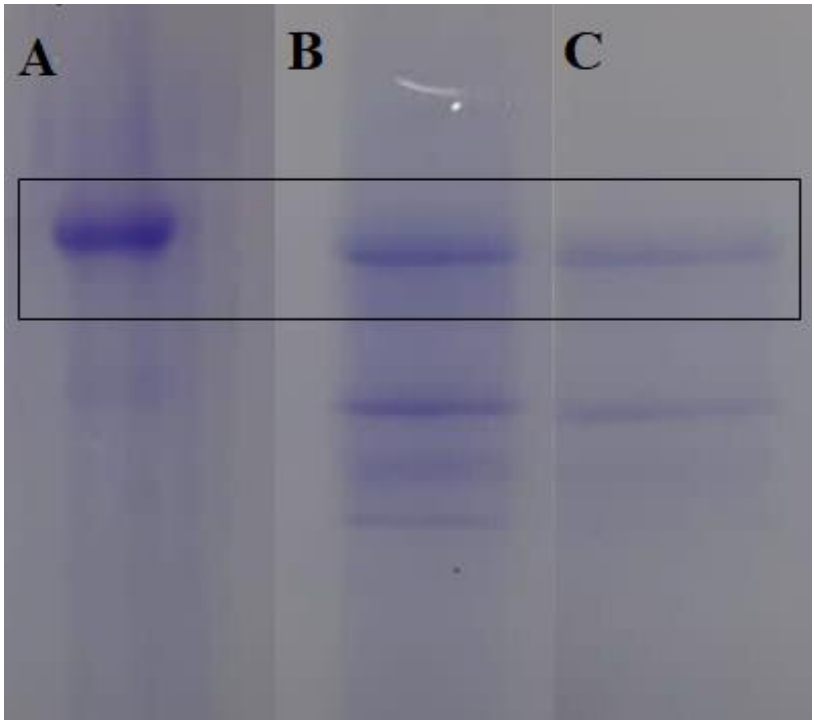
Figure 1. Electrophoresis profile. Application order: ( A ) Lectin BmoLL, ( B ) saline extract and ( C ) fraction.